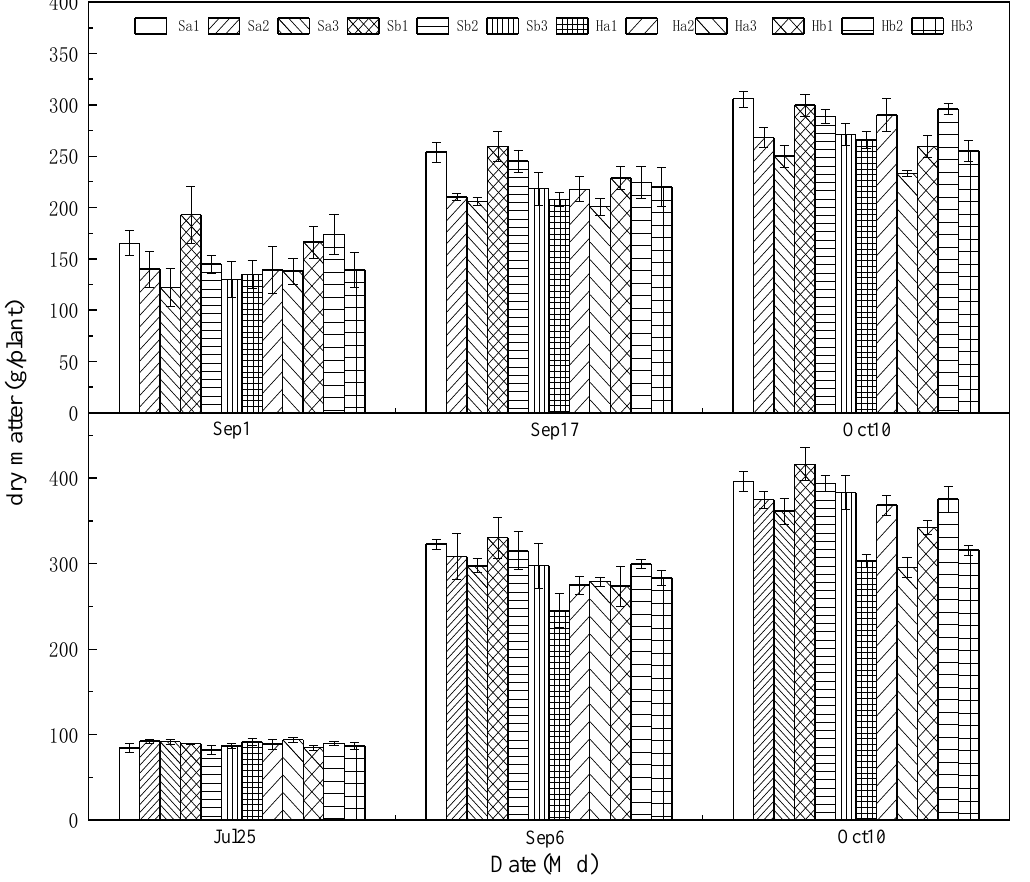
Figure 4. The dry matter accumulation of summer maize in 2016 – 2017.